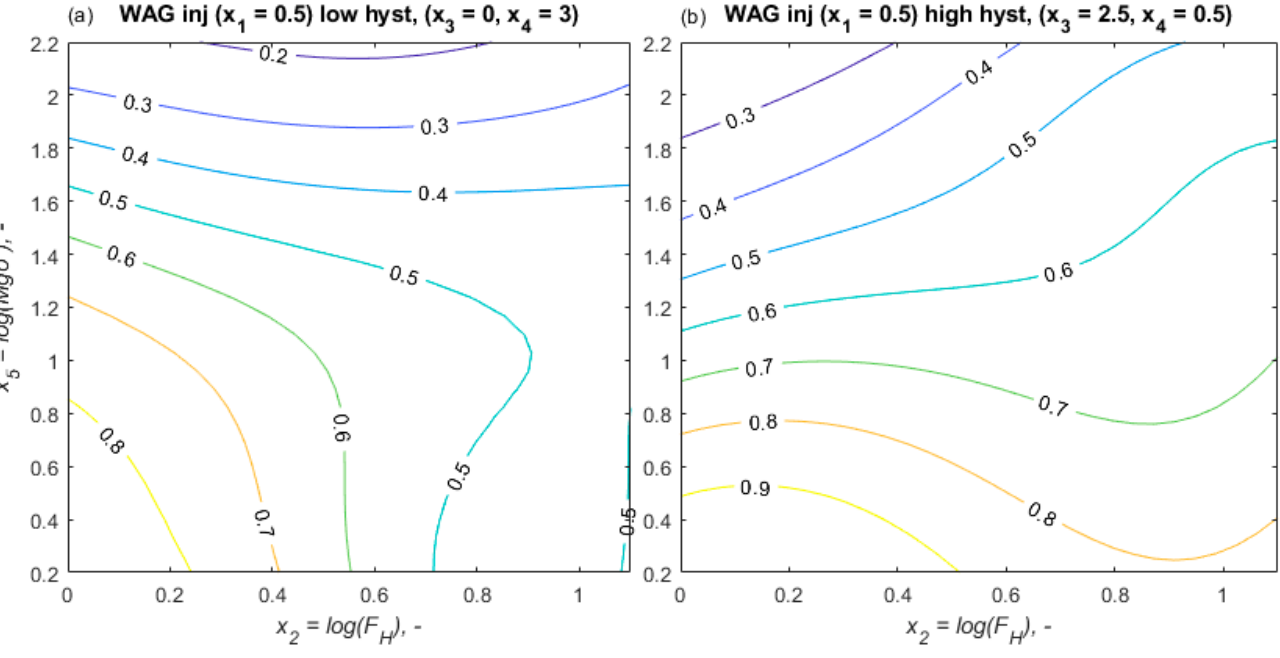
(cid:16) (cid:17) M ∗ go .